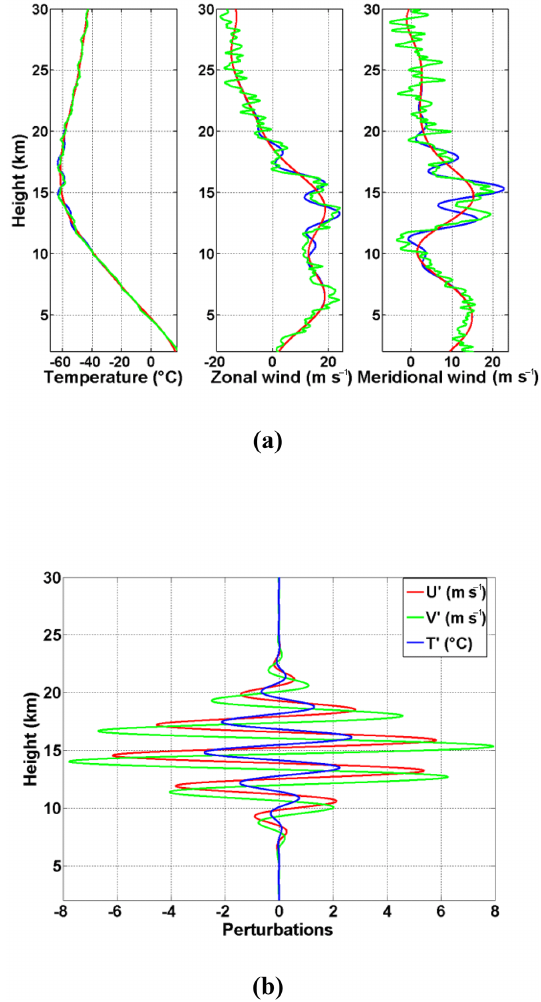
Figure 8. (a) Observed (green solid line) and simulated temperature (blue solid line) in units of ◦ C (left panel) on 27 July at 23:03UTC. The middle and right panels are similar to the left panel but for hor- izontal wind profiles (ms − 1 ) . Red solid lines indicate the observed mean profile. (b) Simulated perturbation profiles using GW sim- plified linear wave polarisation relations. U (cid:48) , V (cid:48) , and T (cid:48) are zonal wind (ms − 1 ) , meridional wind (ms − 1 ) , and temperature ( ◦ C) per- turbations